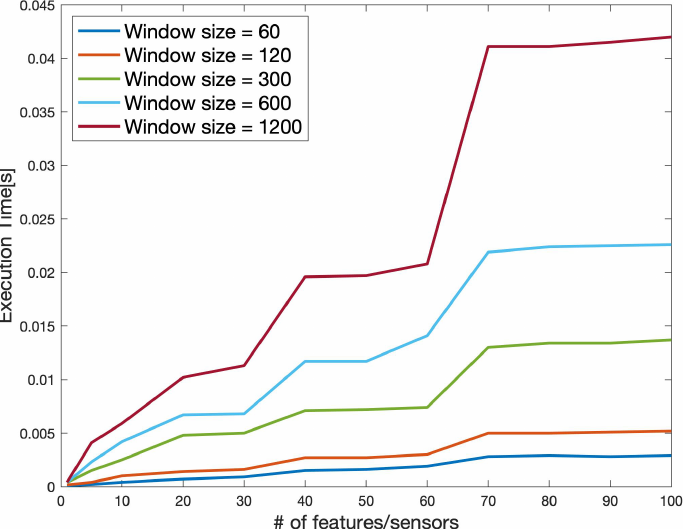
Figure 15. The scalability of the proposed perturbation method according to the number of features and the window size (i.e., the number of